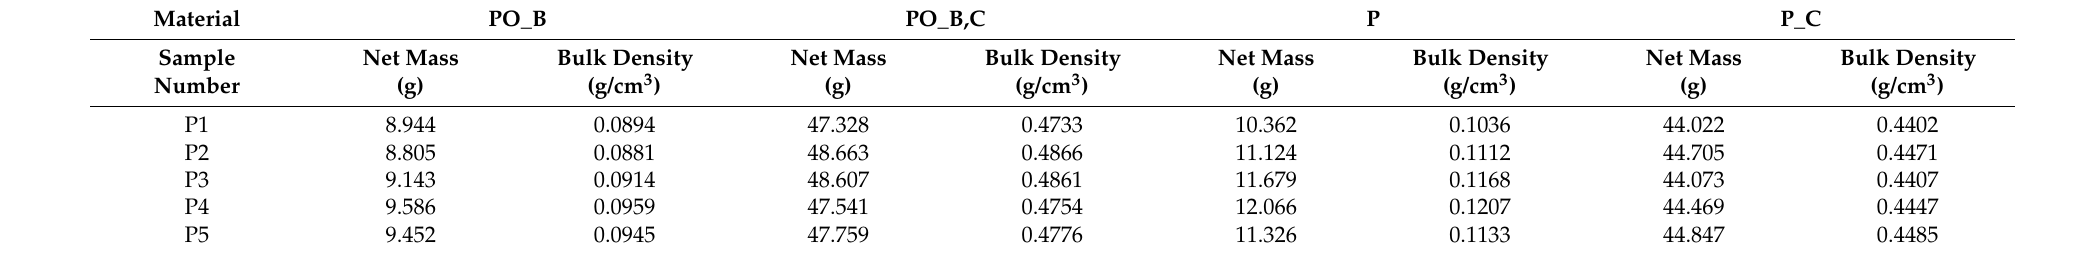
Table A50. Results of bulk density tests of PO_B; PO_B,C; P; and P_C.